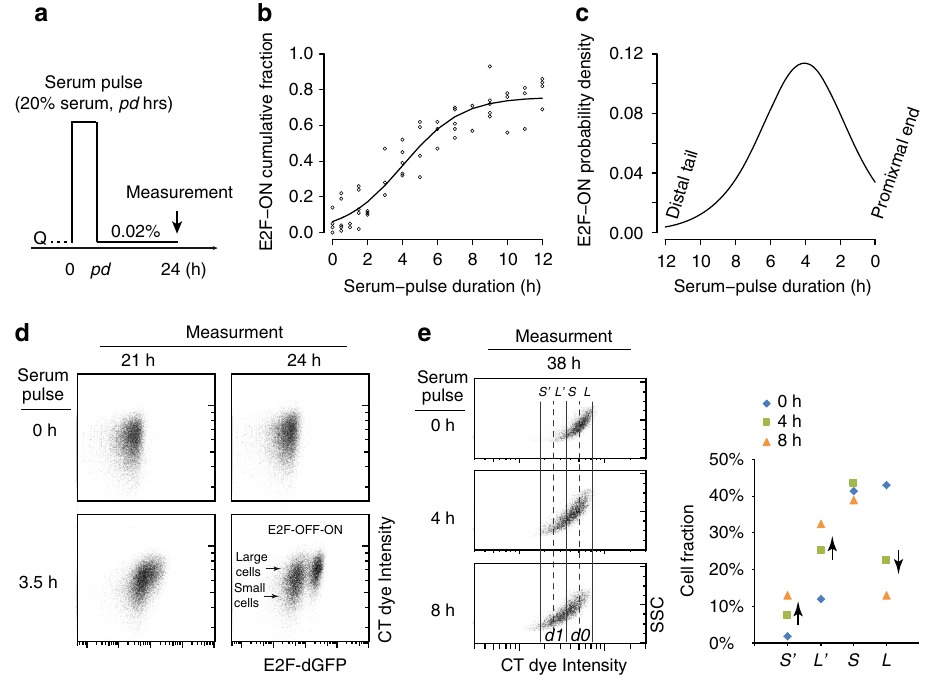
Fig. 1 Quiescence-exit distribution and cell size correlation. a Experimental scheme for measuring quiescence-exit heterogeneity. Q, quiescent state (the same below). b Cumulative fraction of quiescence-exit (E2F-ON) cells over serum pulse duration. Each dot represents a unique sample. The sigmoid curve (cid:1) (cid:3) . c Quiescence-exit distribution as the derivative of the sigmoidal curve in b . d Serum-starved quiescent indicates a best fi t of data points y ¼ a 1 þ e (cid:2) b ð x (cid:2) c Þ REF/E23 cells were stained with CT violet dye at time 0, and stimulated with serum pulse at indicated durations. E2F-dGFP and CT levels were measured at the indicated time points after serum pulse initiation. e Serum-starved, CT-labelled quiescent cells as in d were stimulated with serum pulses at indicated durations. CT dye intensity and SSC were measured at the 38th hour after serum pulse initiation, as shown in the density plot ( left ); the percentage of cells in each labelled CT bin ( S ’ , L ’ , S, L , as described in the text) is shown for each serum pulse group ( right ). For simplicity, CT bins were considered not to overlap. Cells of d1 and d0 labels correspond to those that divided and did not divide following a serum pulse,